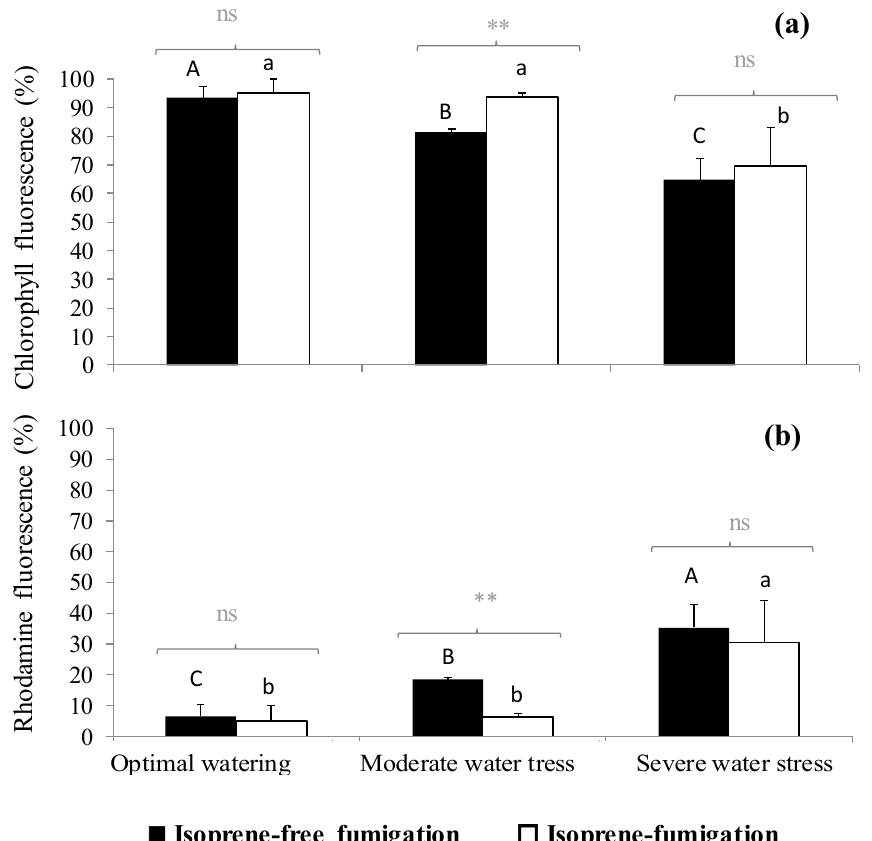
Figure 2. ( a ) Chlorophyll fluorescence intensity and ( b ) rhodamine autofluorescence (expressed in percentage with respect to total fluorescence, so the sum of both fluorescence intensities reaches 100%) under three watering and two fumigation treatments. Differences between fumigated treatments (noted in grey above brackets) within each watering treatment are tested through Mann–Whitney tests (**: 0.001 < p < 0.01, ns: not significant differences). Differences between watering treatments within each fumigation treatment are tested through Kruskal–Wallis tests and are denoted with different letters ( A > B > C for isoprene-free fumigation, a > b for isoprene fumigation). Values are mean ± se, n = 3 (n: number of saplings).